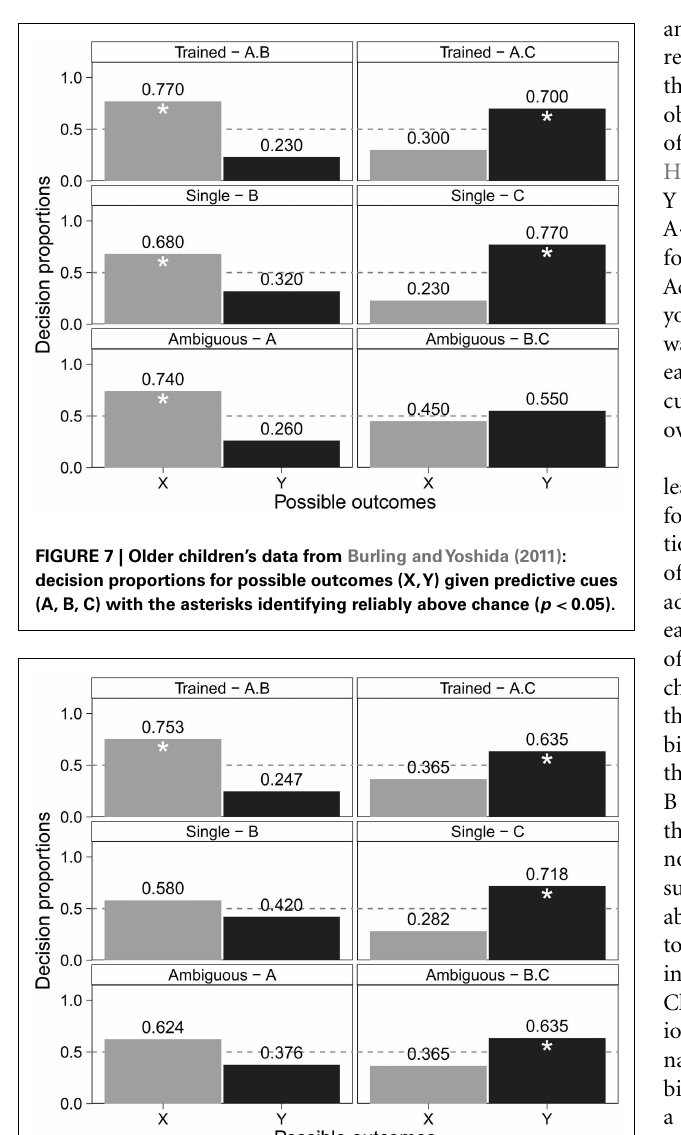
B are equally predictive of X) and isolate B as a single